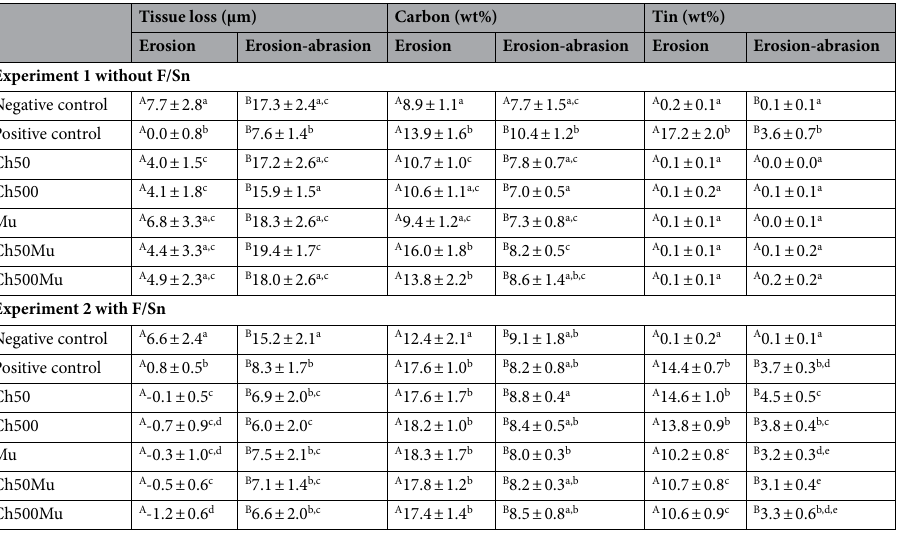
Table 1. Results of profilometry (mean tissue loss ± SD in µm) and EDX analysis (amount of carbon and tin in weight percent (mean wt% ± SD)). Experiment 1 = no F/Sn except for positive control; experiment 2 = application of F/Sn in all experimental groups. Negative Control = without active agents; Positive Control = F/Sn only; Ch50/Ch500 = chitosan with viscosities of 50 mPas/500 mPas; Mu = porcine gastric mucin; Ch50Mu/Ch500Mu = combination of chitosan and mucin in separate solutions. Different lowercase letters indicate statistically significant differences between groups within one experiment (experiment 1 or experiment 2) and one condition (erosion or erosion-abrasion). Significant differences between corresponding groups of the two conditions (erosion and erosion-abrasion) are marked with differing capital